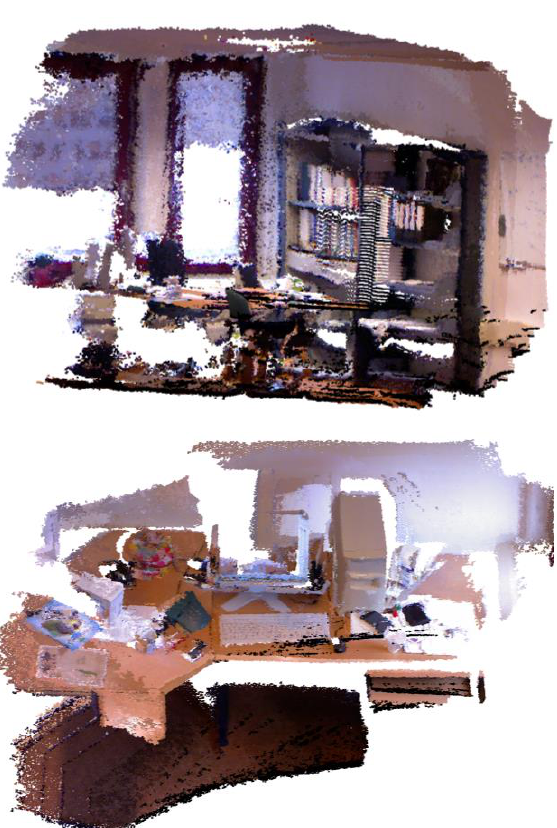
Figure 4. Closing distance (a) and closing angle (b) for six RGB-D sequences registered with and without weights.